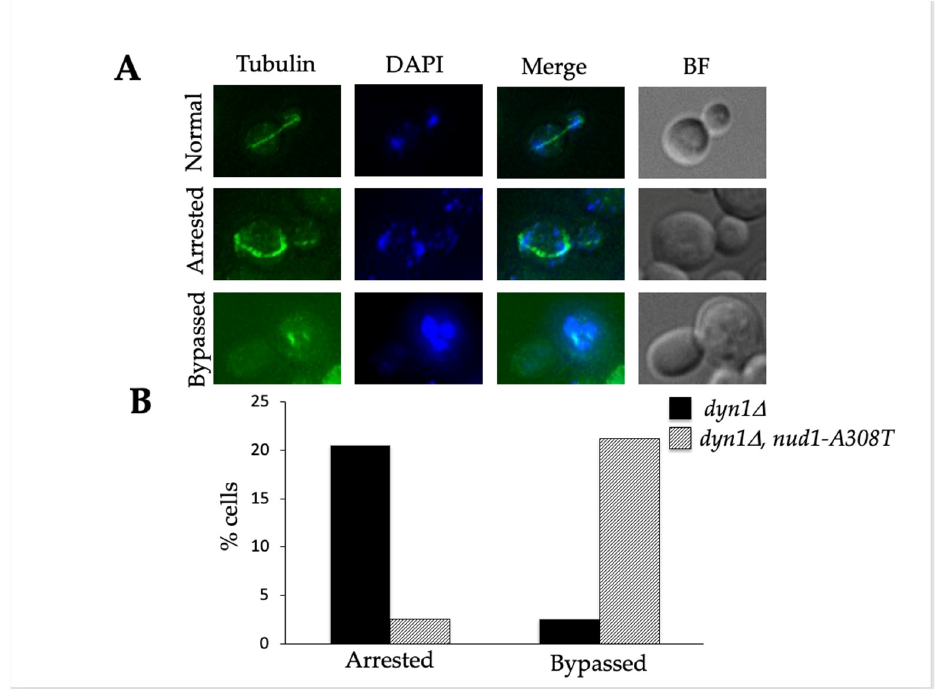
Figure 3. The nud1-A308T allele causes bypass of the Spindle Position Checkpoint (SPoC). Log phase wild-type (AS417) and nud1-A308T (AS474) cells containing both dyn1 Δ and GFP-TUB1 were grown at 14 °C for 25 h to induce spindle mispositioning. Samples were collected and the cells were fixed with paraformaldehyde and stained with DAPI prior to imaging. ( A ) Representative images of a cell undergoing a proper anaphase (normal), arrested in anaphase with a mispositioned spindle (arrested), and with multiple nuclei and spindles indicating SPoC bypass (bypassed) are shown. ( B ) The percentage of cells from each strain with arrested or bypassed morphology was plotted ( n > 500).